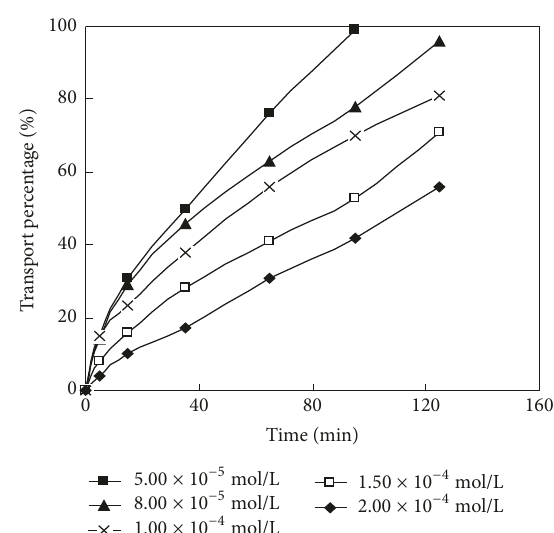
Figure 5: Effect of initial concentrations on transport of